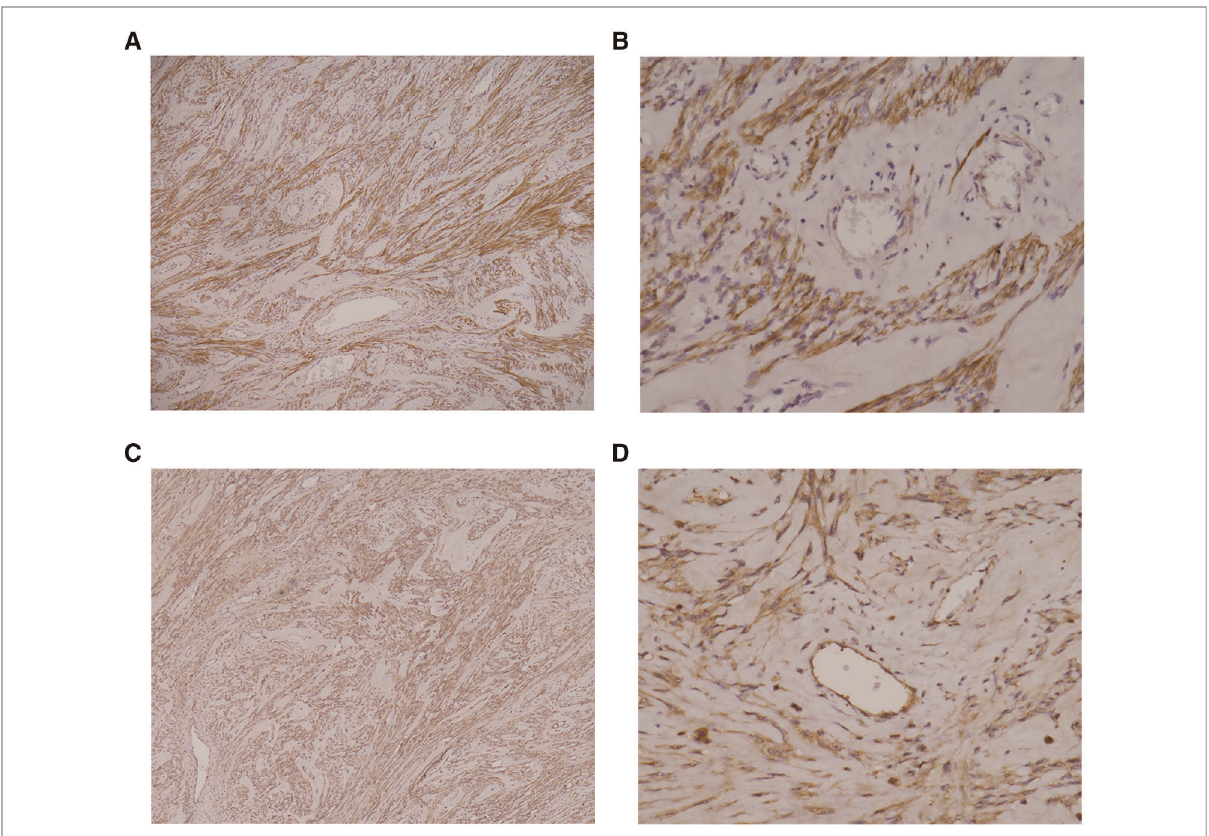
FIGURE 2 ( A – D ): Immunohistochemical staining revealed excessive Epo and Epo-R expression of the broad ligament myoma. Immunochemical staining showed diffuse (>50%) Epo expression with moderate to strong staining intensity over the myomatous cells ( A , 40×), whereas the endothelial cells were negatively stained ( B , 200×). A diffuse (>50%) Epo-R expression with moderate staining intensity was found over the myomatous cells ( C , 40×). The endothelial cells also presented with diffuse, moderate to weak staining intensity ( D , 200×). EPO, erythropoietin; Epo-R, erythropoietin